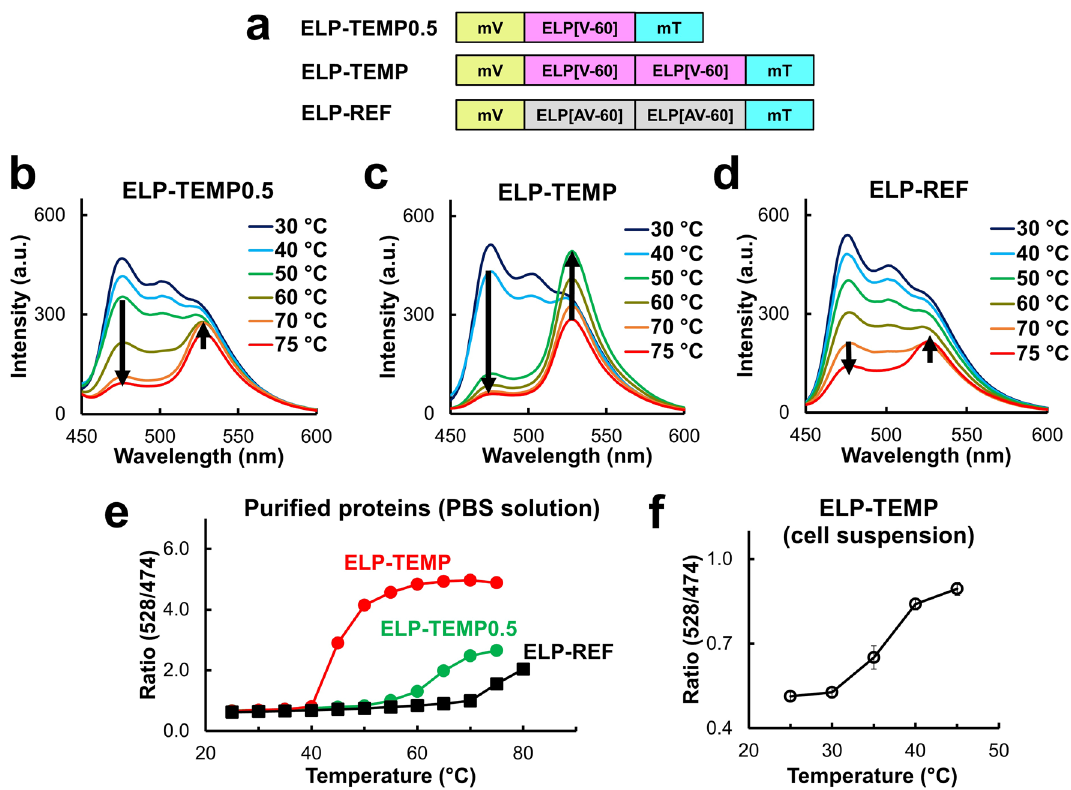
Figure 1. Temperature response of ELP-TEMP0.5, ELP-TEMP, and ELP-reference (ELP-REF). ( a ) Gene design of ELP-TEMP0.5, ELP-TEMP, and ELP-REF. ( b – d ) The fluorescence emission spectrum of ( b ) ELP-TEMP0.5, ( c ) ELP-TEMP, and ( d ) ELP-REF at various temperatures. ( e ) A plot of fluorescence ratio of mV (peak emission, 528 nm) to mT (peak emission, 474 nm) of ELP-TEMP0.5, ELP-TEMP, and ELP-REF against temperature. ( f ) A plot of fluorescence ratio of ELP-TEMP in HeLa cell suspension against temperature. Purified proteins (2 µM) were dissolved in a PBS solution (pH 7.4). The excitation wavelength was 430 nm. Data are mean ± SD ( n =